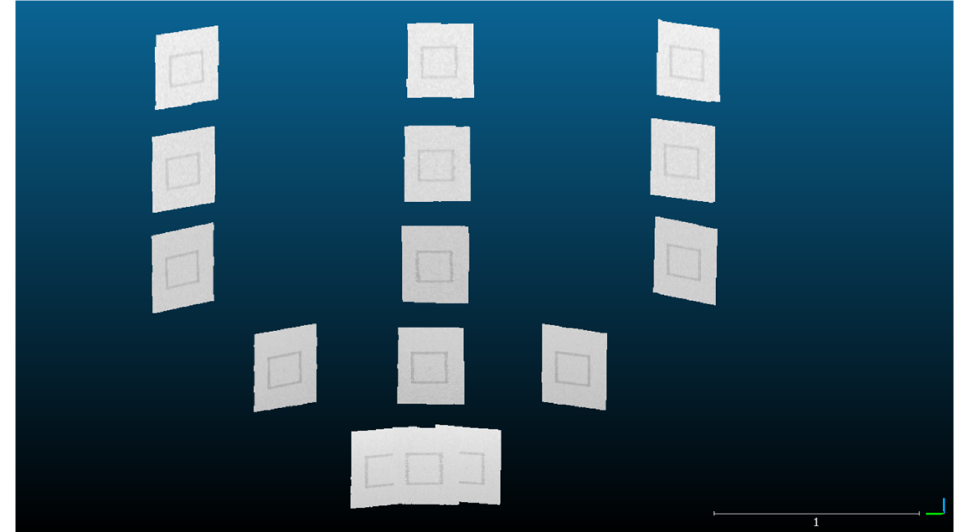
Figure 8. Each FARO scan is clipped to only contain the sample board. Edge artifacts are trimmed from the boundaries of each board.